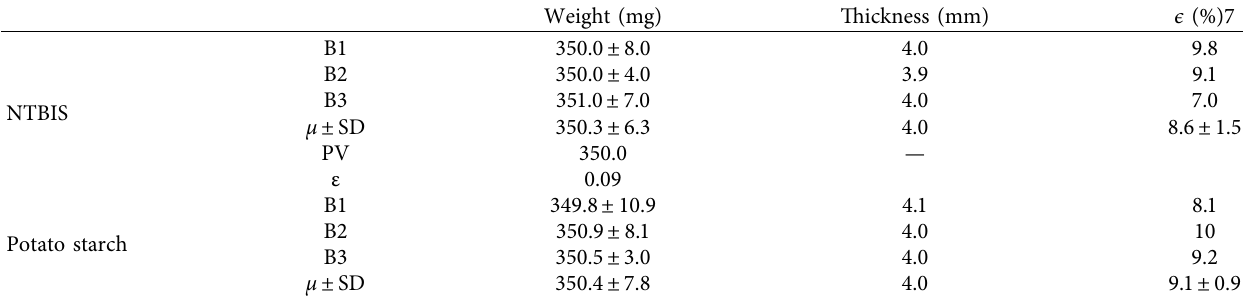
Table 4: The weight, thickness, and porosity of tablets prepared with NTBIS and potato starch at optimum levels of factors.